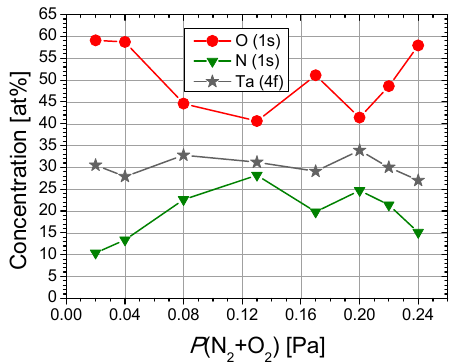
Figure 1. Atomic concentration of the films, as a function of the reactive mixture partial pressure, obtained from O (1s), N (1s), and Ta (4f) of XPS spectra.